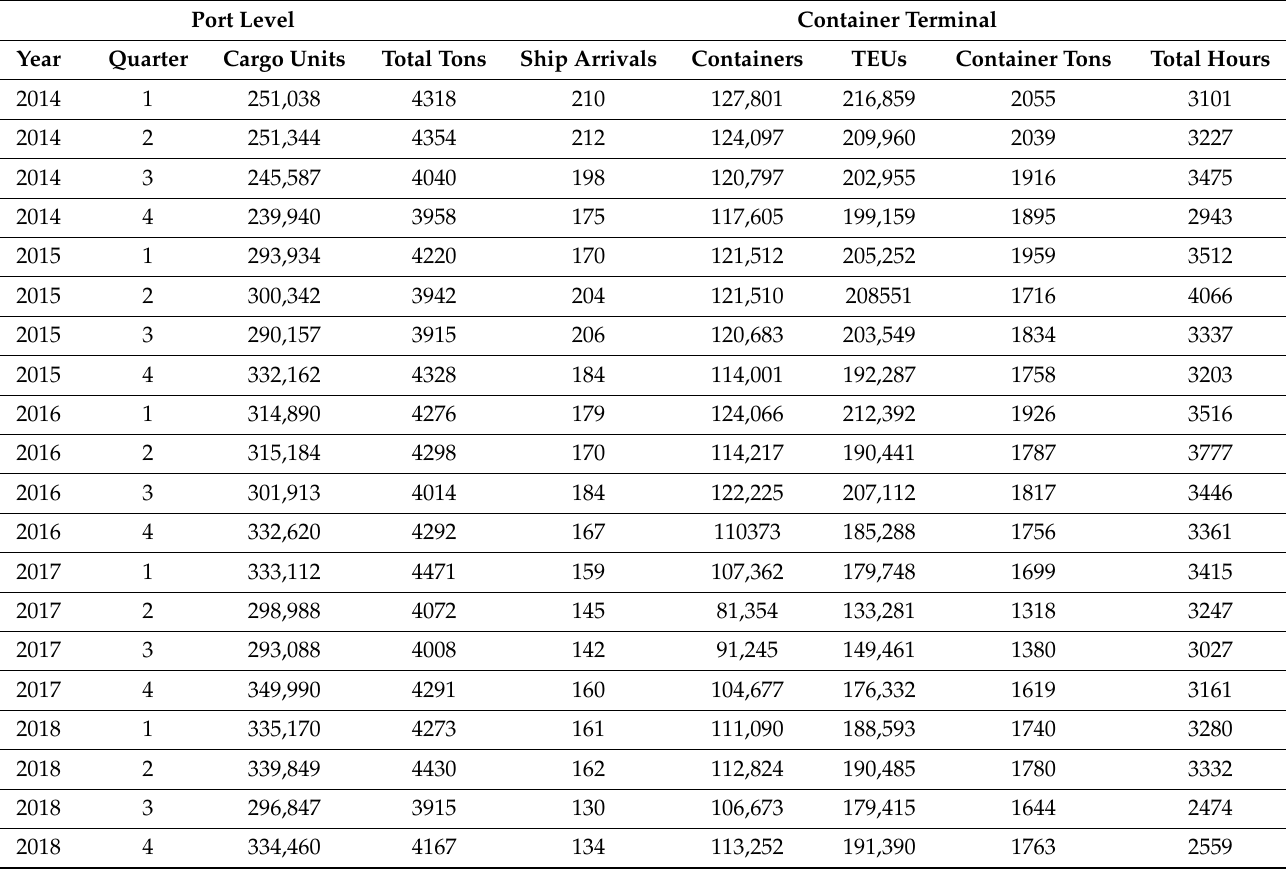
Table 2. Base Statistics for the Port of